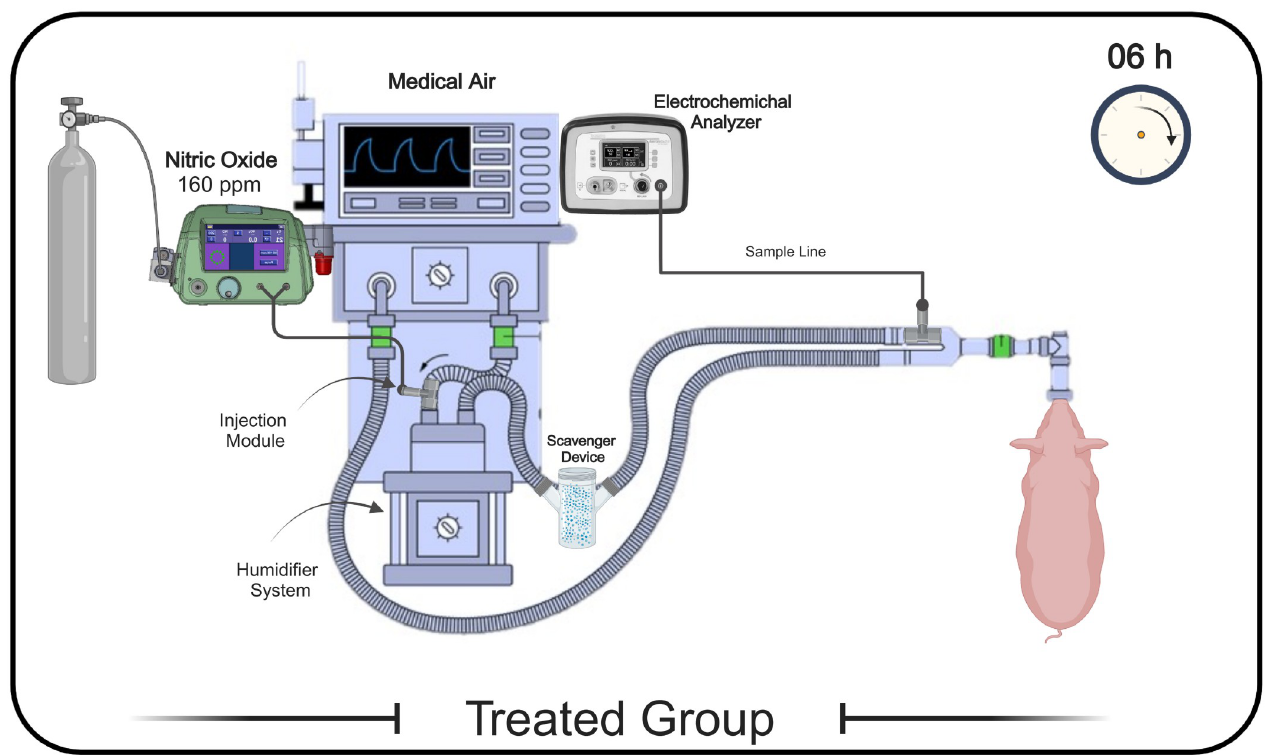
Fig 2. Schematic representation of the inhaled nitric oxide delivery system, and its components location. iNO was delivered for 6 hours continuously to reach the target dose of 160 ppm using a medical-grade pressurized cylinder of 2,000 ppm with a custom digital gas regulator device. The gas was administered through a connector attached to the breathing circuit to deliver NO during predetermined ventilation settings using an ICU ventilator. Inspiratory NO and NO 2 levels were monitored in real-time using a dedicated gas electrochemical analyzer sampling from a port of the inspiratory limb of the ventilatory circuit, proximal to the endotracheal tube. A multi-absorber scavenger device was used to maintain NO 2 below a safety threshold ( < 5 ppm), and was placed right after the humidification system. Definition of abbreviations: ppm = parts per million, iNO = inhaled nitric oxide, NO 2 = nitrogen dioxide, ICU = intensive care unit, h = hours.